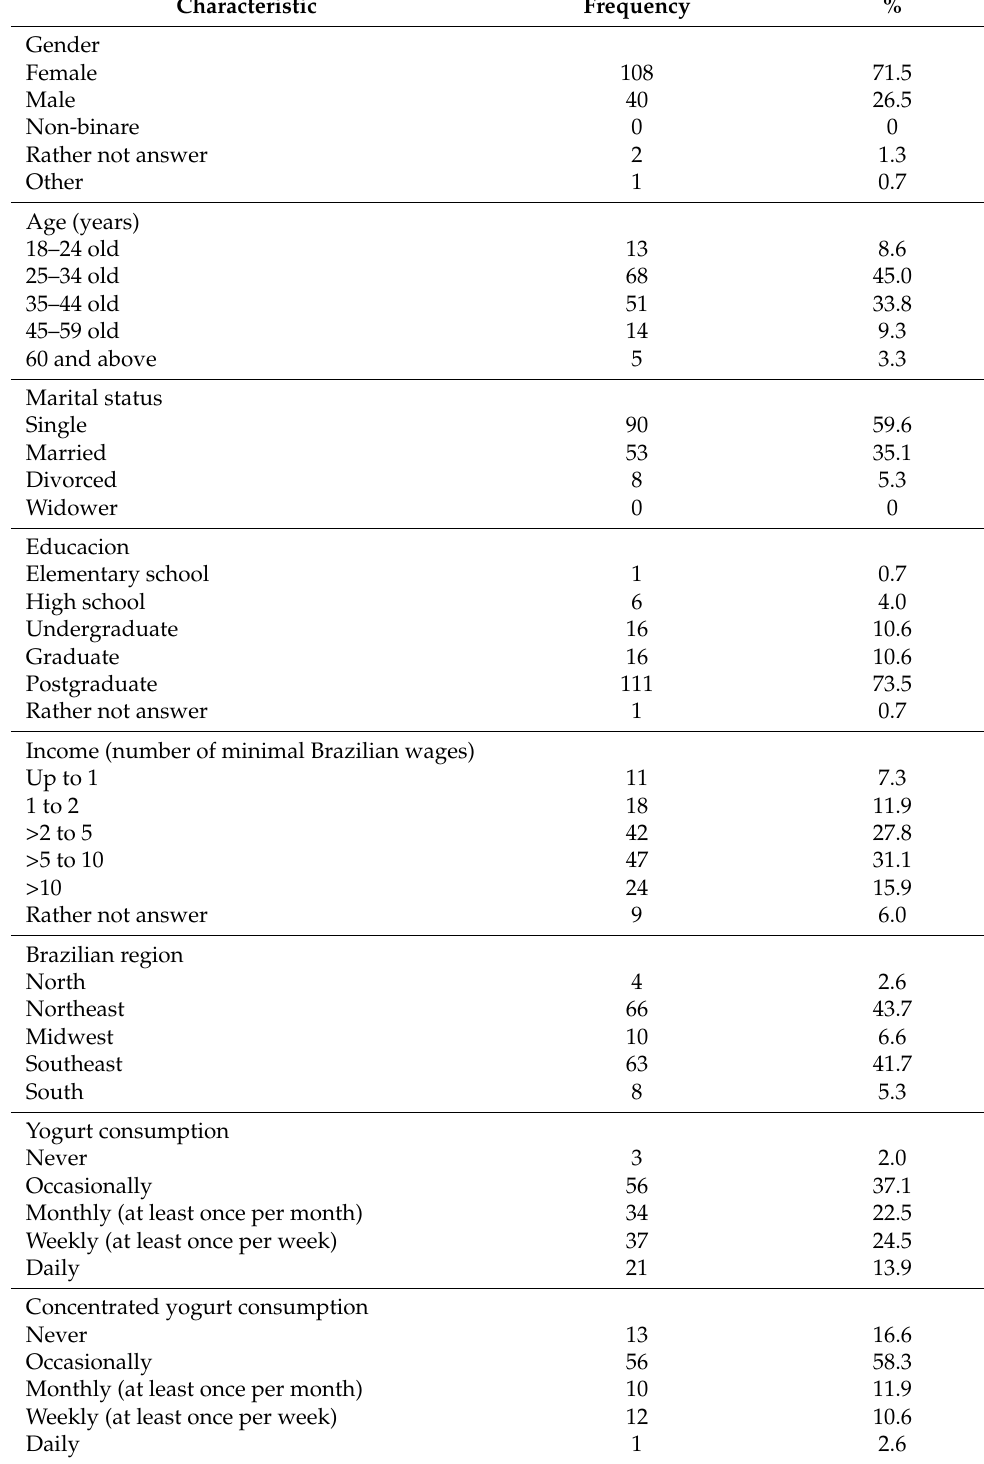
Table 1. Demographic information of survey